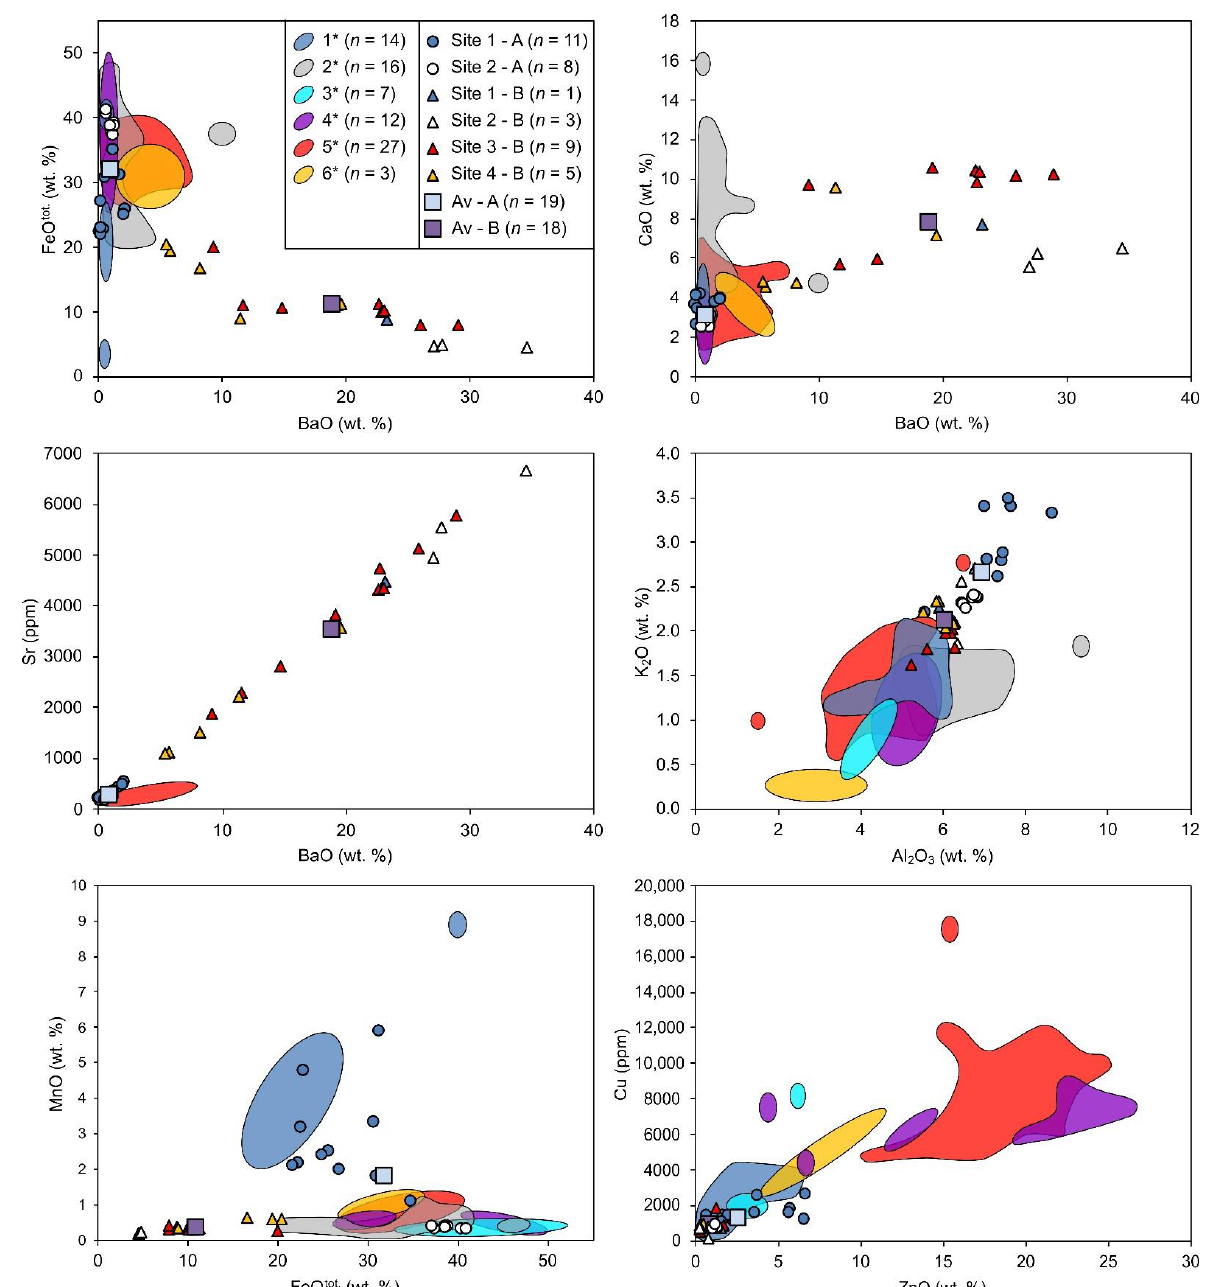
Figure 3. Selected bivariate plots highlighting the differences in bulk chemical composition of the Type A and B slags from individual sites. Av — average, comparative data: 1* —Příbram (Czech Re- the Type A and B slags from individual sites. Av—average, comparative data: 1*—Pˇr í bram public; [8]), 2* — Wiesloch (Germany; [9]), 3* — Kutná Hora (Czech Republic; [6]), 4* — Harz (Ger- many; [40]), 5* — Harz (Germany; [41]), 6* — Harz (Germany; [42]). (Czech Republic; [8]), 2*—Wiesloch (Germany; [9]), 3*—Kutn á Hora (Czech Republic; [6]), 4*—Harz (Germany; [40]), 5*—Harz (Germany; [41]), 6*—Harz (Germany;